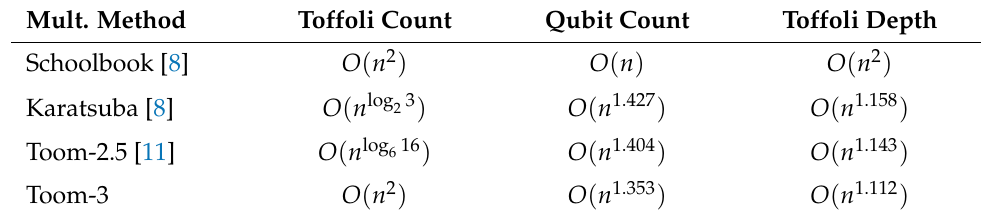
Table 2. Asymptotic Complexity of Several Quantum Multiplication